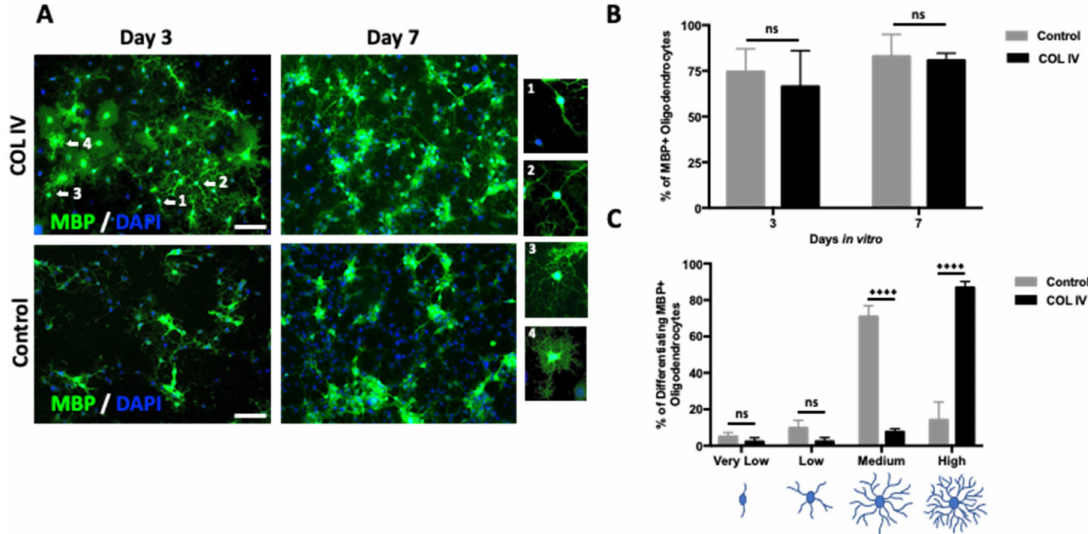
Figure 3. Collagen IV boosts OL maturation. The presence of COL IV accelerates the maturation of cultured NSCs to mature OLs. We identified four distinct morphologies (see bottom figure) of MBP+ cells, from immature OLs displaying primary processes with very low or low numbers of secondary branches to more mature multipolar OLs showing a medium or high degree of branching. ( A ) Representative fluorescence images displaying MBP+ (green) cells after 3 and 7 days of incubation under oligodendrogenic stimulus (control), supplemented or not supplemented with COL IV. DAPI was used for nuclear counterstaining (blue). Scale bar = 50 µ m. Examples of four distinguishable MBP+ cells morphologies (arrows) are shown at high magnification with increasing complexity: (1) bipolar cells with a very low degree of branching; (2) multipolar cells with a low degree of branching; (3) multipolar cells with a medium degree of branching; and (4) multipolar, highly ramified cells. ( B ) Quantitative analysis showing the proportion of MBP+ cells among the total cell number after 3 and 7 days of incubation with COL IV and the control conditions. Note that no significant differences in MBP+ expression were found between the different conditions. ( C ) Quantitative analysis of the MBP+ cell morphology distribution after 3 days of incubation with COL IV and control